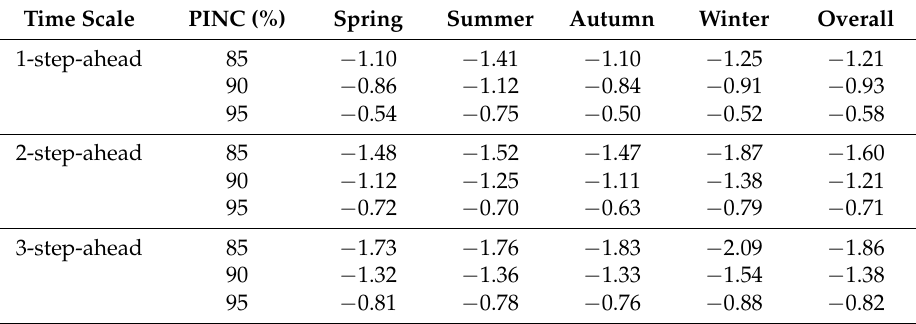
Table 6. The criterion IS of probabilistic wind speed forecasting using WTD-RNN-ANFIS. Time Scale PINC